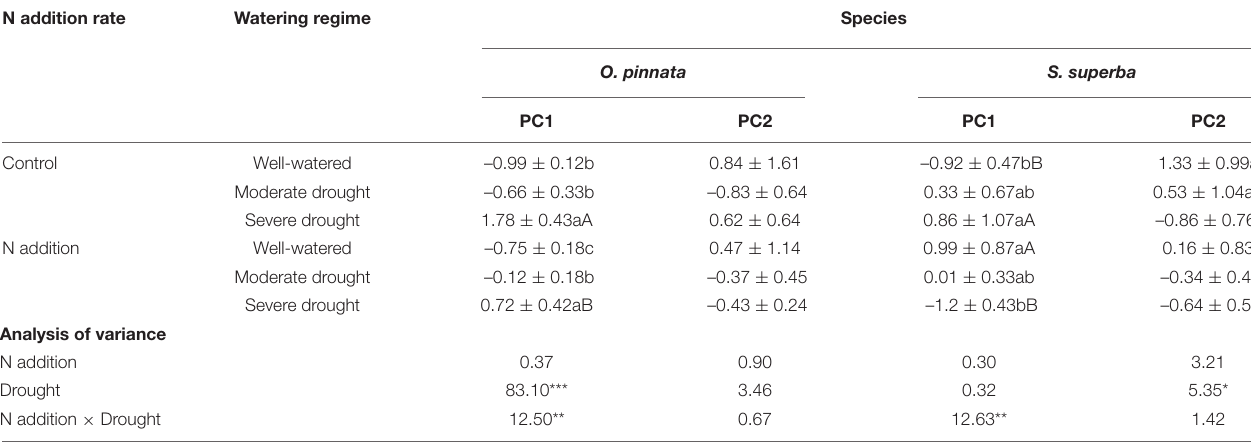
TABLE 2 | N addition, drought, and their interactive effects on the first and second principal component scores of the physiological and anatomical traits of two tree species. N addition